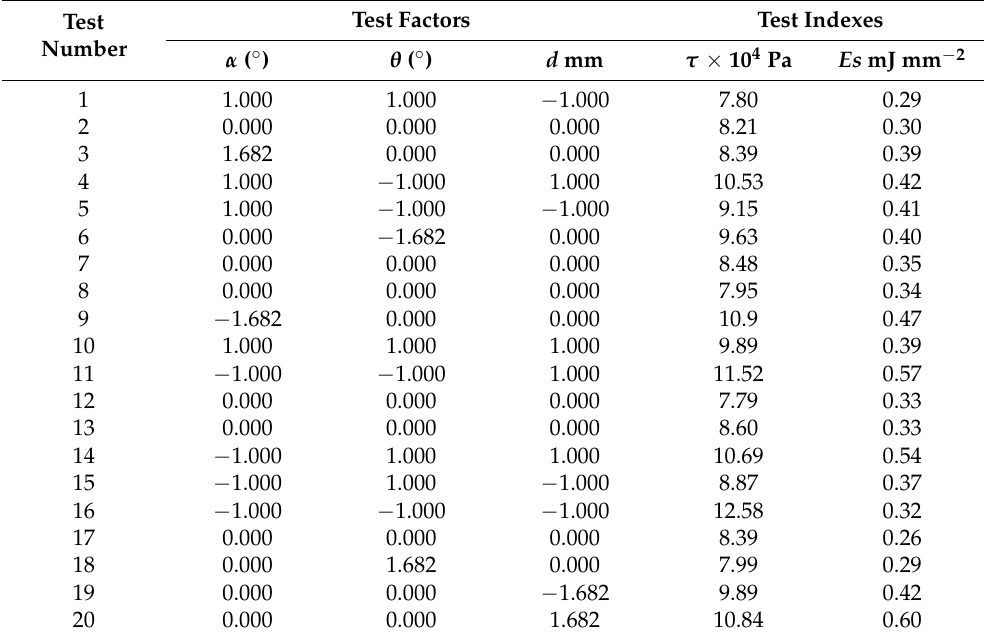
Table 3. Design and results of the RSM test.